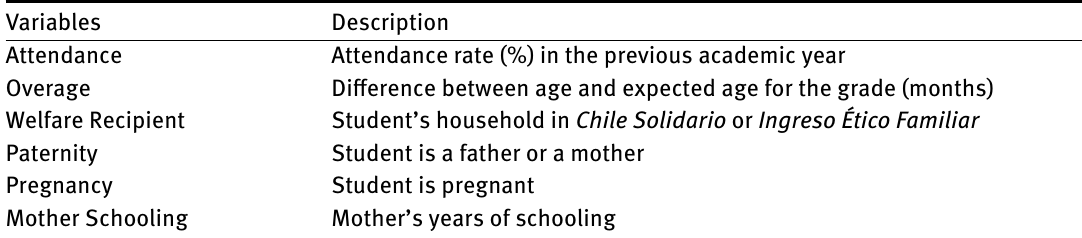
Table 1: IVSE Variables